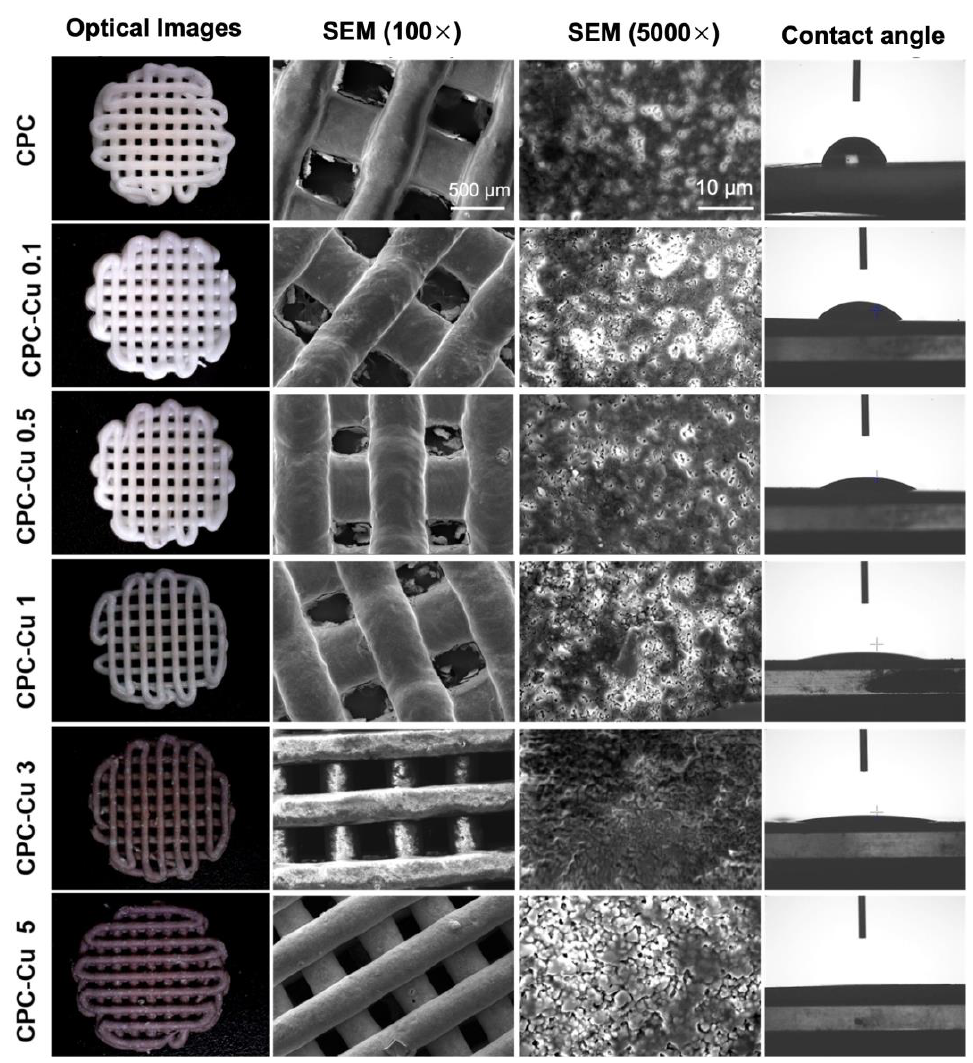
Figure 1. The characterization of as printed scaffolds imaged under optical microscopy (left panel 1) scanning electron microscopy images at 100× and 5000× showing the top surface morphology of the scaffolds (panel 2 and 3) and wettability of the scaffolds with images taken using a contact angle goniometer showing the change in contact angle lower with Cu loaded CPC scaffolds compared to CPC.